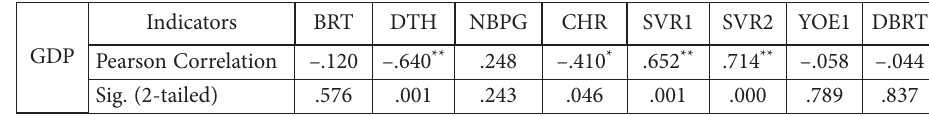
Table 13. The values of Pearson Correlation between GDP and factorial variables for Cluster C Indicators BRT DTH NBPG CHR SVR1 SVR2 YOE1 DBRT GDP Pearson Correlation –.120 –.640 ** .248 –.410 * .652 ** .714 ** –.058 –.044 Sig. (2-tailed) .576 .001 .243 .046 .001 .000 .789 .837